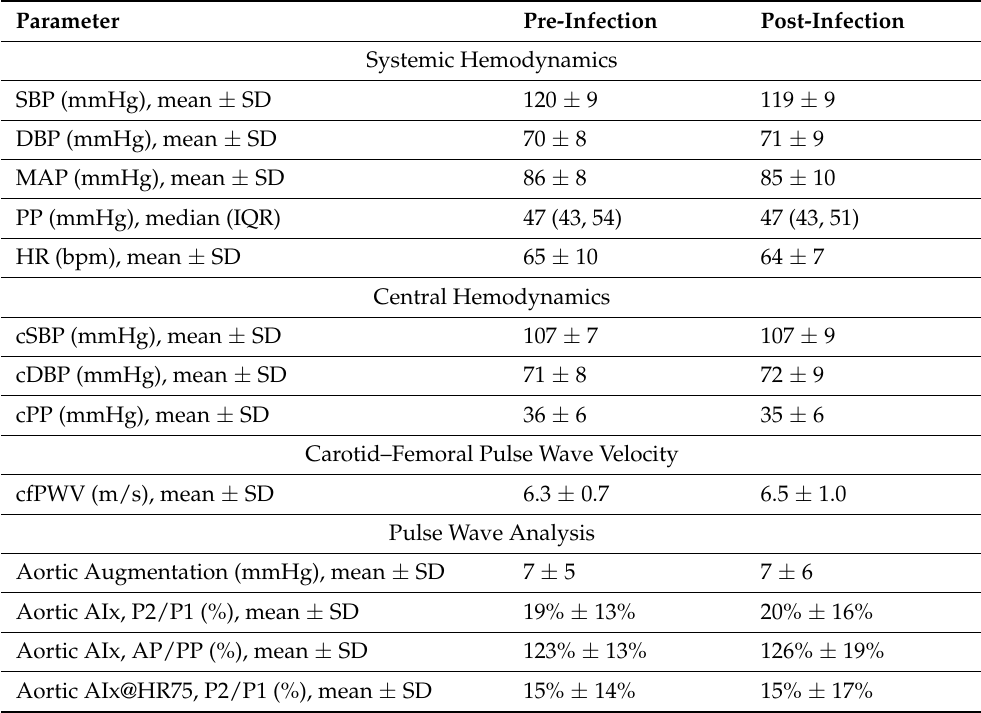
Table 2. Distribution of arterial stiffness, and central and systemic hemodynamic parameters at baseline (pre-infection) and 2–3 months after the onset of COVID-19 disease (post-infection), N = 32. Parameter Pre-Infection